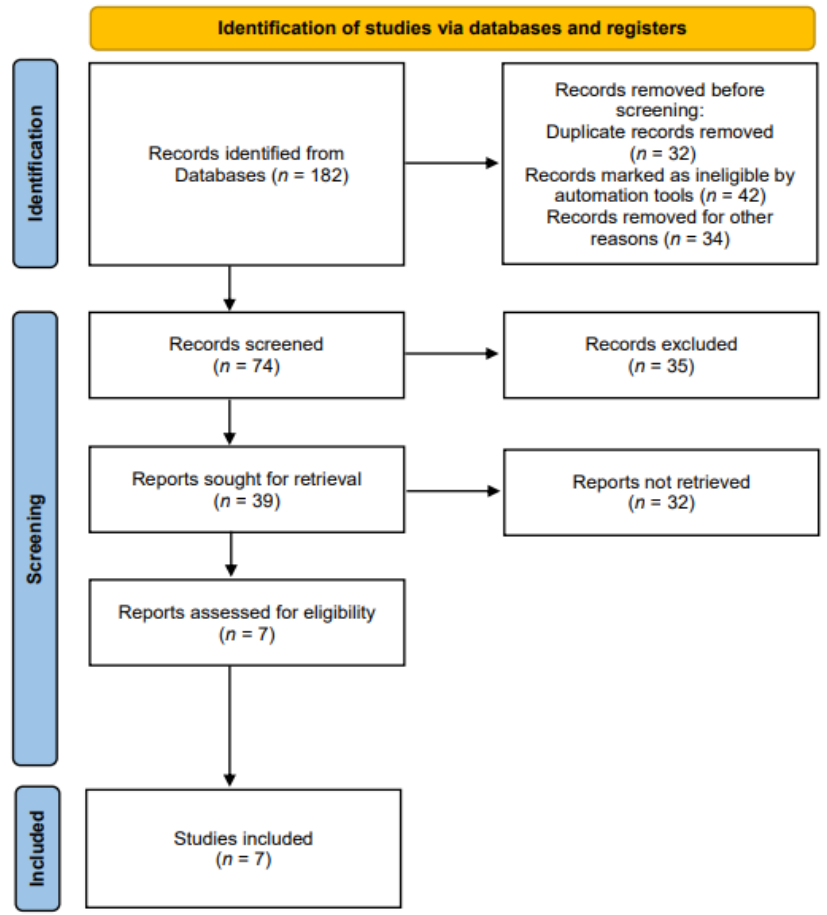
Figure 1. The preferred reporting items for systematic reviews and meta-analyses (PRISMA) flow chart. flow